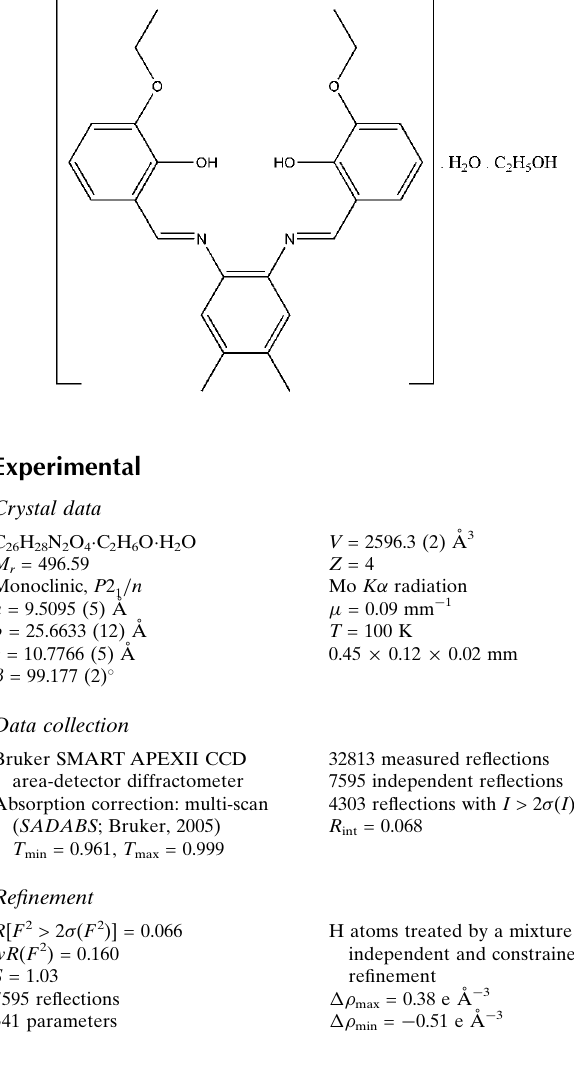
Hydrogen-bond geometry (A ˚ , (cid:2)